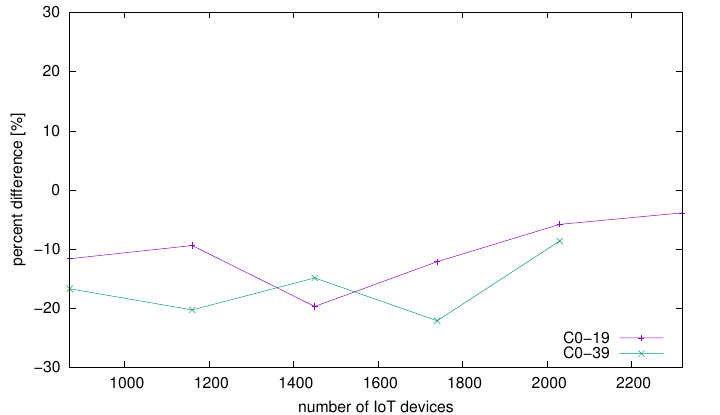
− t docker . t physical